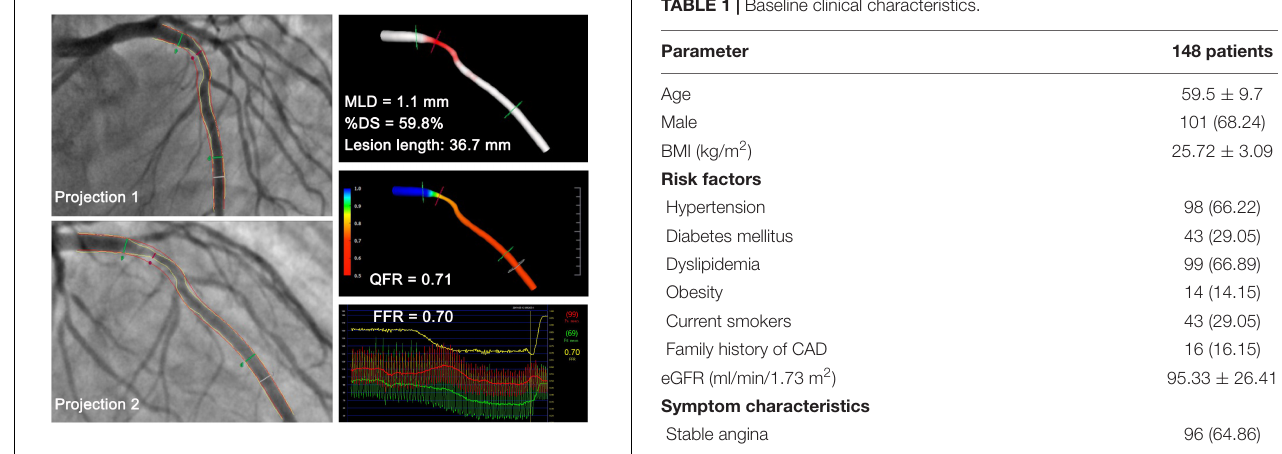
FIGURE 2 | Representative case in a 53-year-old man with a minimal lumen diameter of 1.1 mm at the lesion site. QFR derived from the two projections was 0.71, which was in accordance with the FFR measurement of 0.70. MLD, minimal lumen diameter; %DS, percent diameter stenosis; QFR, quantitative flow ratio; FFR, fractional flow reserve.